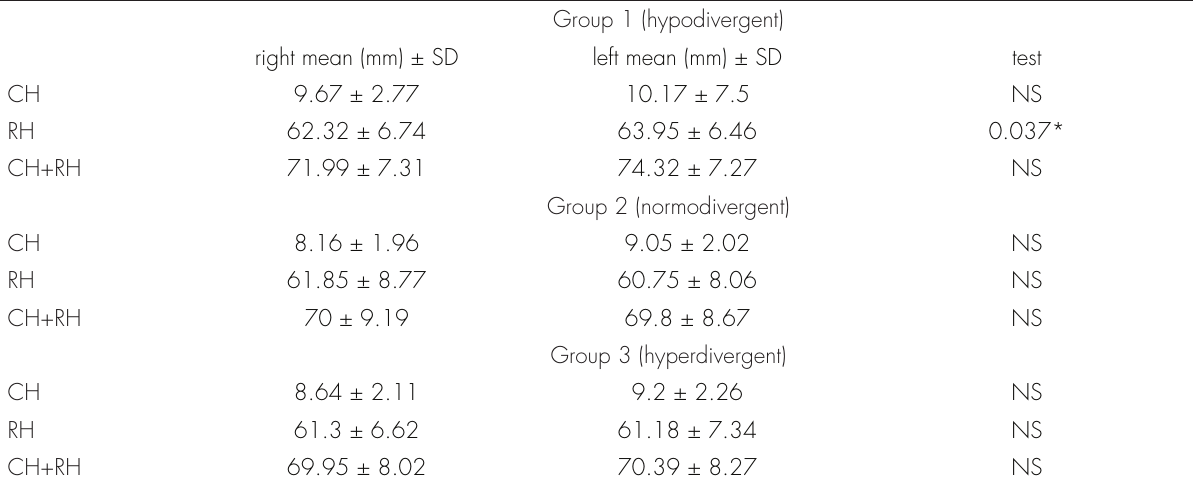
Table III. The comparison of the right and left side measurements according to the vertical skeletal